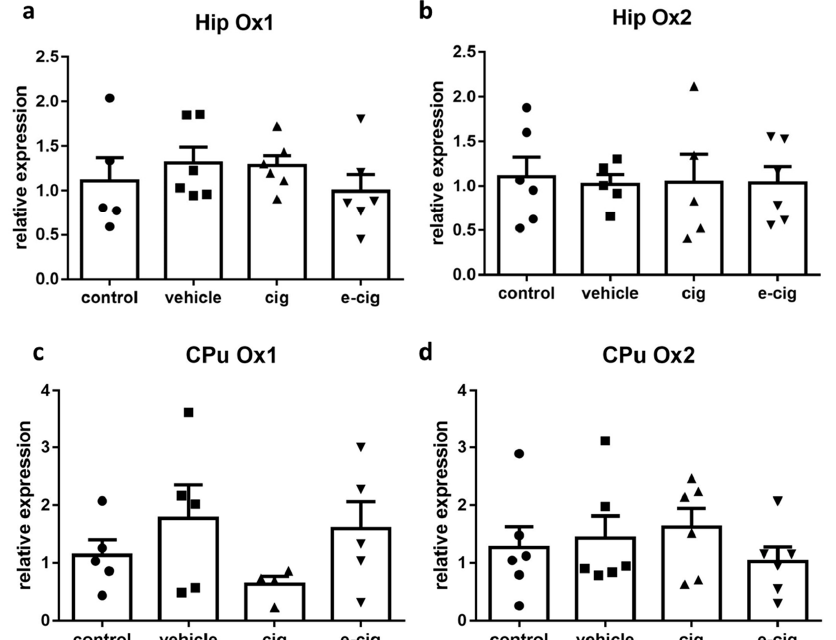
Figure 6. Relative mRNA levels of orexin receptors Ox1 ( a , c ), or Ox2 ( b , d ) after e-cigarette (e-cig, downward triangle) or cigarette (cig, upward triangle) exposure, with respect to exposure to air (control, circle) or an e-cigarette administration vehicle (vehicle, square). The results displayed in panels ( a , b ) were obtained in the hippocampus, while panels ( c , d ) show the results of the CPu. The mice were exposed to cigarettes or e-cigarettes for 7 weeks, followed by a 60-day withdrawal. n = 4–6 for each group. Hip: hippocampus; CPu: caudate-putamen.